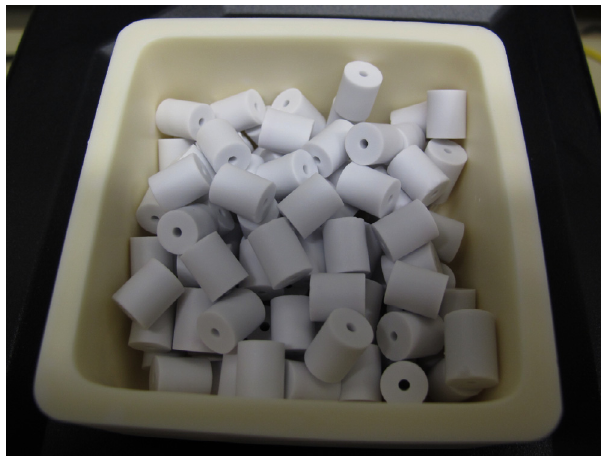
Fig. 3. Sintered pellets in the alumina container (100 pellets).